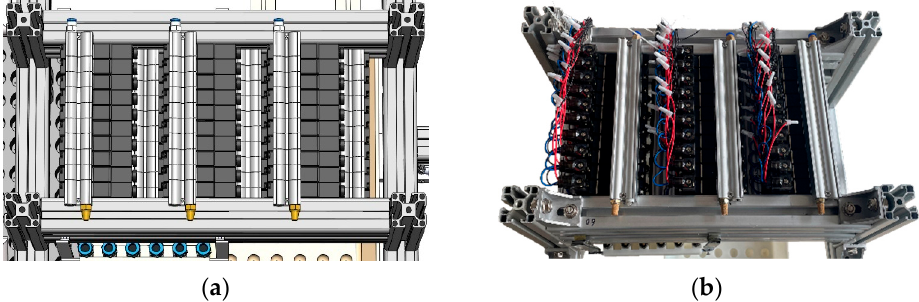
Figure 4. Air source control device. ( a ) Three-dimensional (3D) diagram. ( b ) Object diagram.